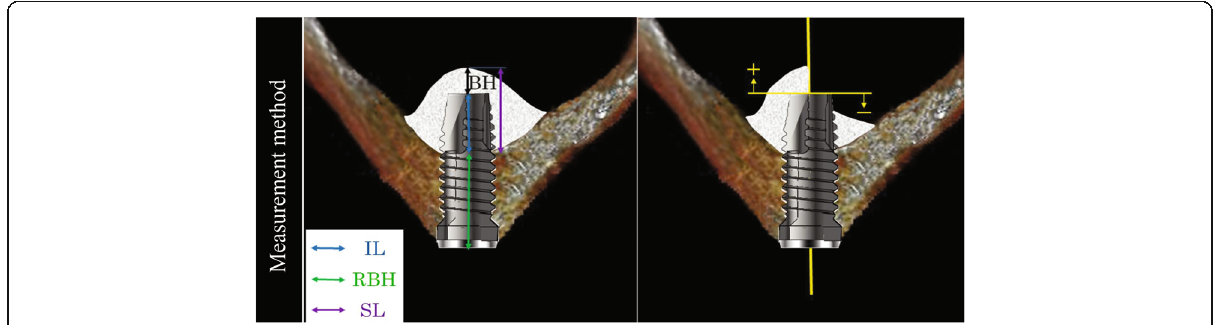
Fig. 3 Measurement method using CBCT. Radiographic examination on the coronal cross-section images parallel to the longitudinal direction of the implant. The linear variables include height of the augmented bone above apex of the implant (BH), height of the augmented sinus floor (SL), implant length that projected into the sinus (IL), residual bone height